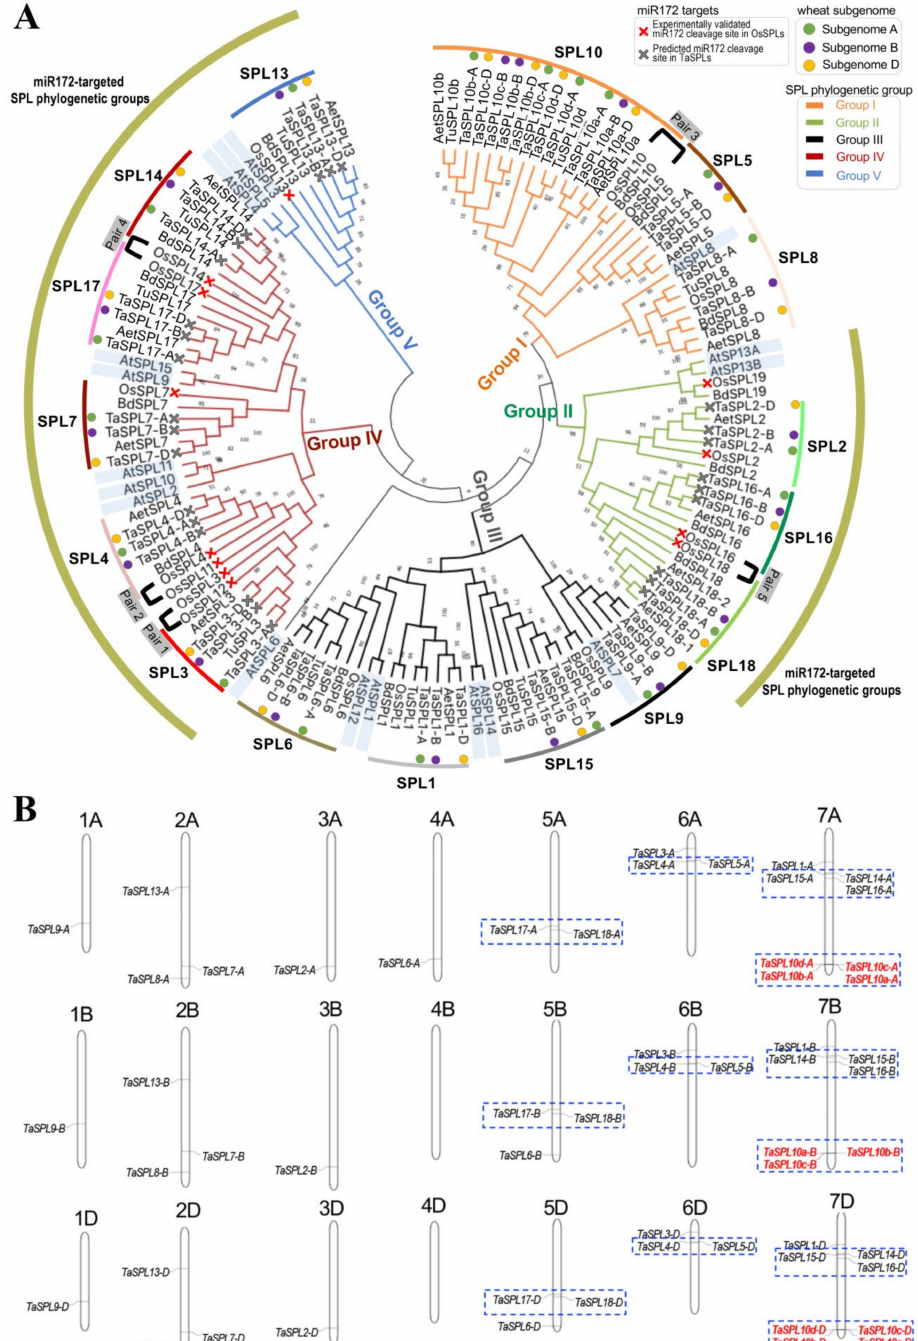
Figure 1. Phylogenetic analysis of TaSPL s highlighting the orthologous relationship between OsSPL s and TaSPL s: ( A ) Phylogenetic tree constructed by maximum-likelihood method grouped TaSPL s together with their orthologs in rice, providing results consistent with the syntenic analysis of SPL genes between rice and wheat (Figure S2, Table S1); ( B ) diagram of the chromosomal locations of TaSPL genes, identifying several TaSPL clusters and gene expansion at the TaSPL10 locus driven by tandem duplications. TaSPL gene clusters are shown by blue boxes and the tandemly duplicated genes of TaSPL10 are highlighted in